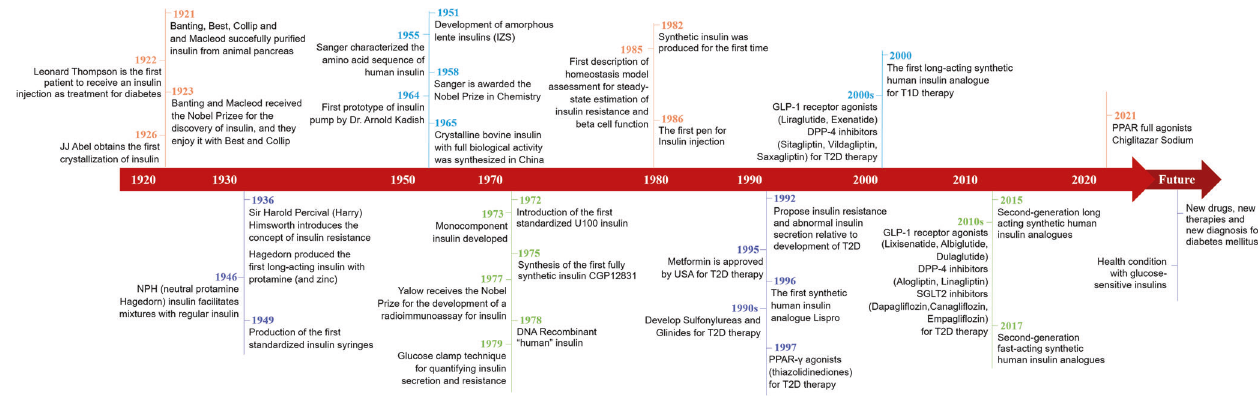
Fig. 1 A timeline of key discoveries in our understanding of insulin and insulin